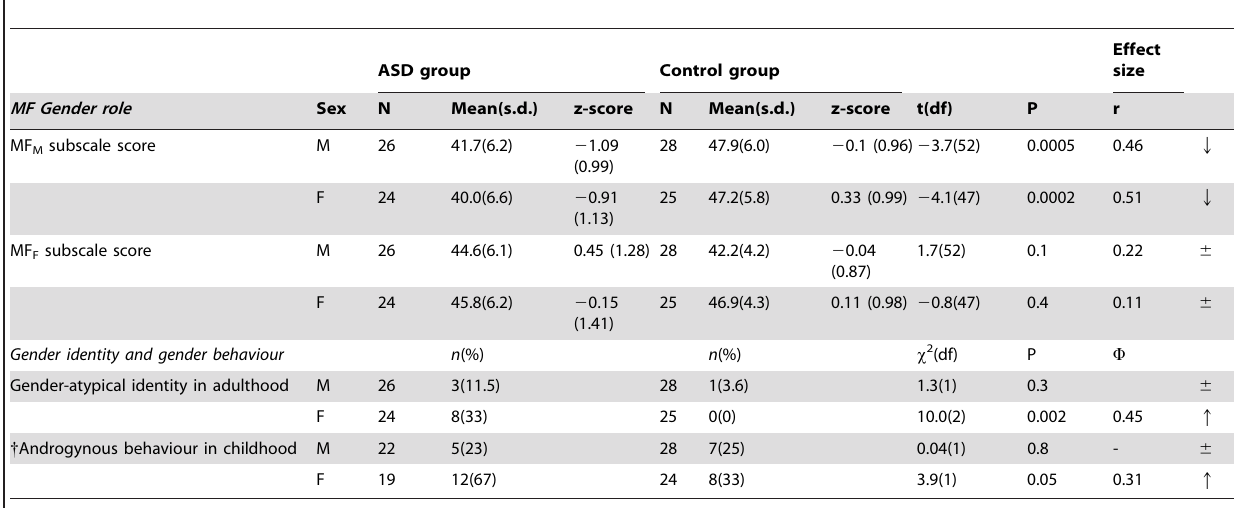
Table 3. Gender role and gender identity measures in 50 individuals with autism spectrum disorder (ASD) and 53 neurotypical